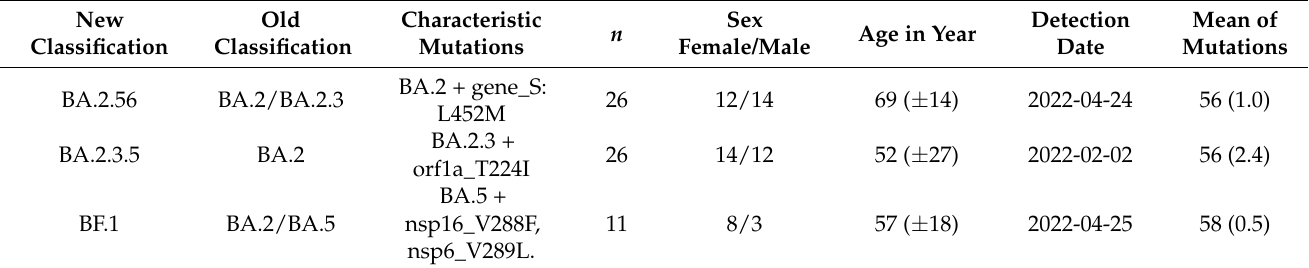
Table 2. New Omicron variants circulating in Asturias according pangolin